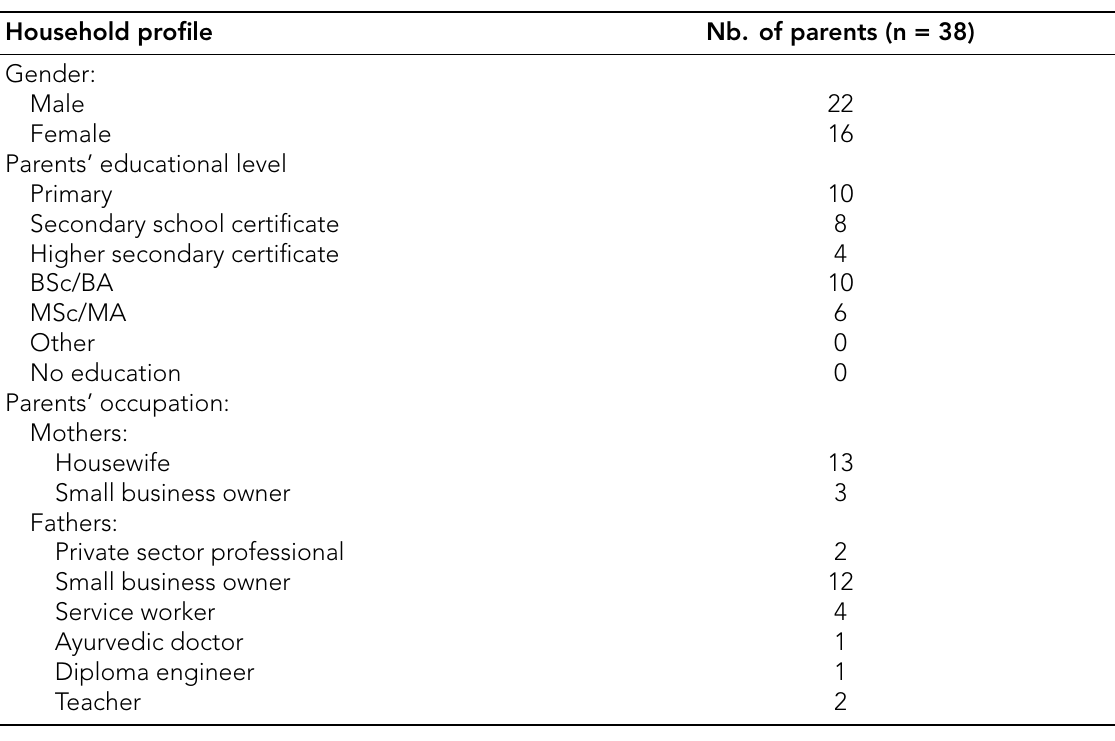
Table 1. Household profile (Source: Authors, 2022) Household